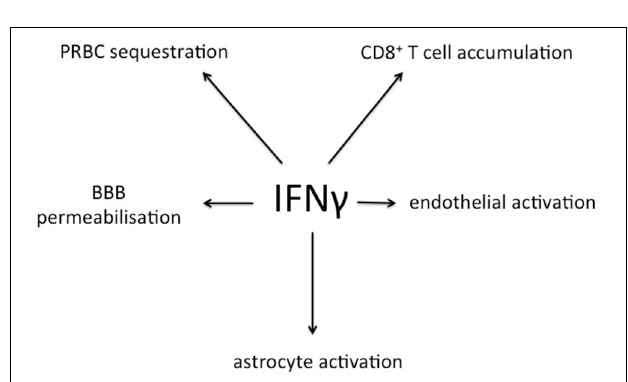
FIGURE 7 | Summary of processes relevant to cerebral malaria that are stimulated by IFN- γ , as derived from experimental models. PRBC, parasitized red blood cell; BBB, blood-brain barrier.